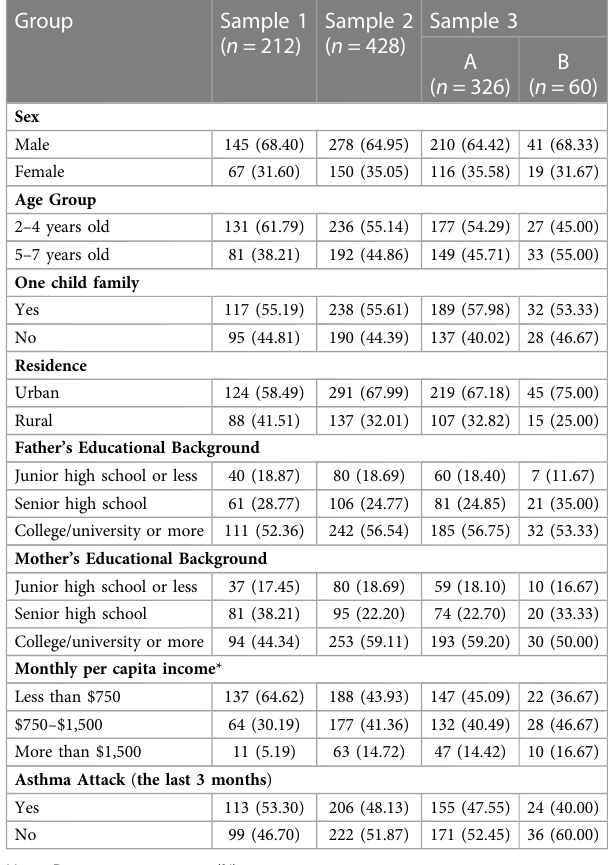
TABLE 1 Demographic characteristics of the children with asthma and their caregivers ’ samples in three investigations.